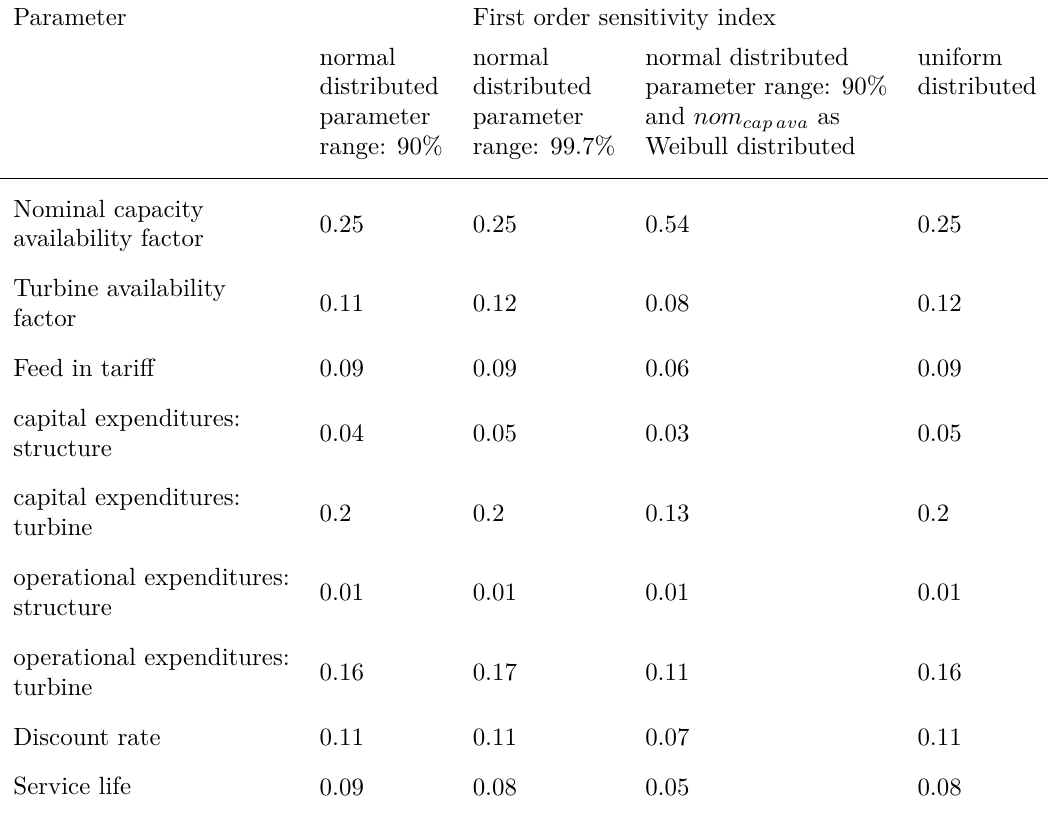
Table 6. First order sensitivity indices of the different input